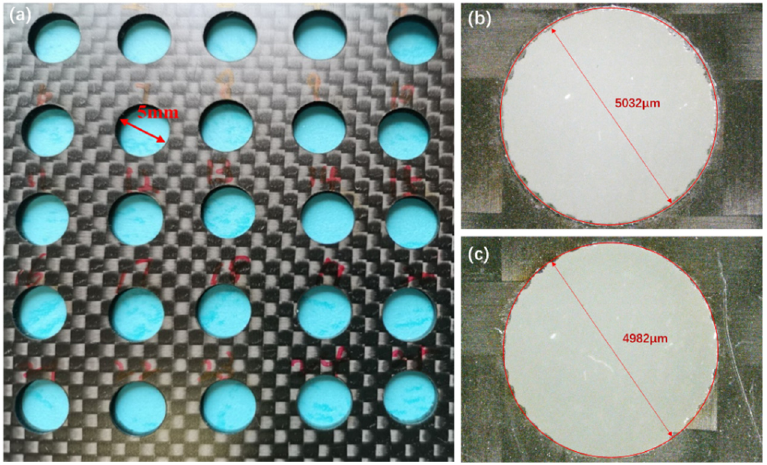
Figure 4. ( a ) Cutting holes in CFRP plate with nanosecond lasers for Sample 1-1 to Sample 5-5; ( b ) inlet of the CFRP laser cutting hole of sample 5-3; ( c ) outlet of the CFRP laser cutting hole of sample 5-3.